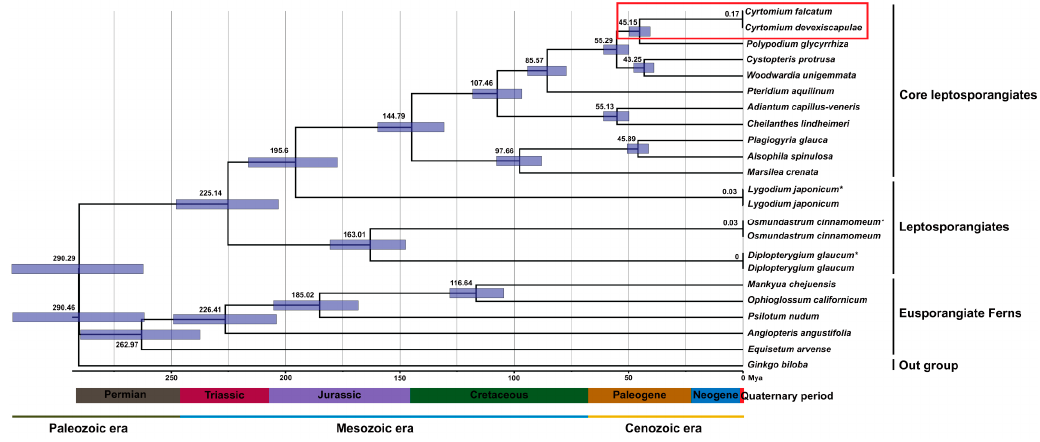
Figure 9. The molecular clock was constructed based on 76 protein ‐ coding genes of 23 different fern taxa cp genomes using the Bayesian Evolutionary Analysis Sampling Trees (BEAST) software program. Mean age estimates (in millions of years) are shown along the branches. The gray bars represent the 95% posterior density credibility interval for node ages. * Fossil data cp genomes were used to identify the molecular age of the corresponding taxa.